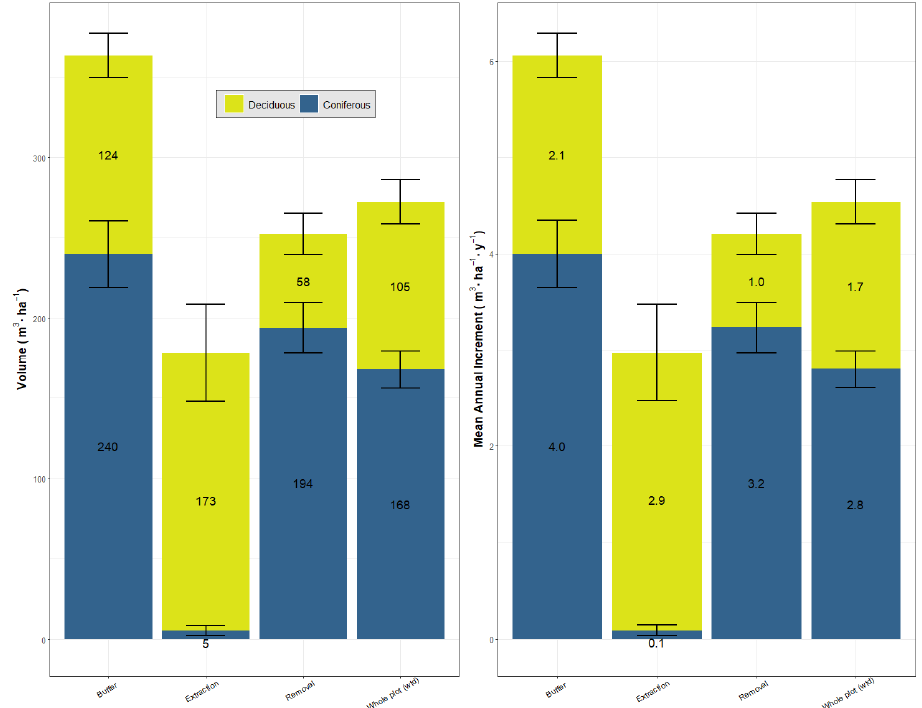
Figure 7. MGM predictions of MAI (mean annual increment) and merchantable volume by treatment at year 60 (70–72 years after the SCUP harvest). Numbers show treatment weighted means (plot within block); error bars show standard error of the mean.